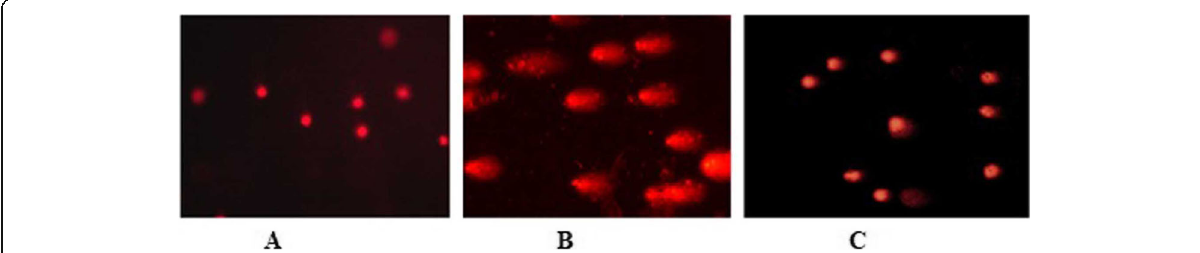
Fig. 2 Representative photographs depict the extent of DNA damage in HeLa cells treated with control and isolated compound from Terminalia chebula . a Untreated HeLa cells. b Control (HeLa cells treated with 50 μ M H 2 O 2 ). c Control + isolated